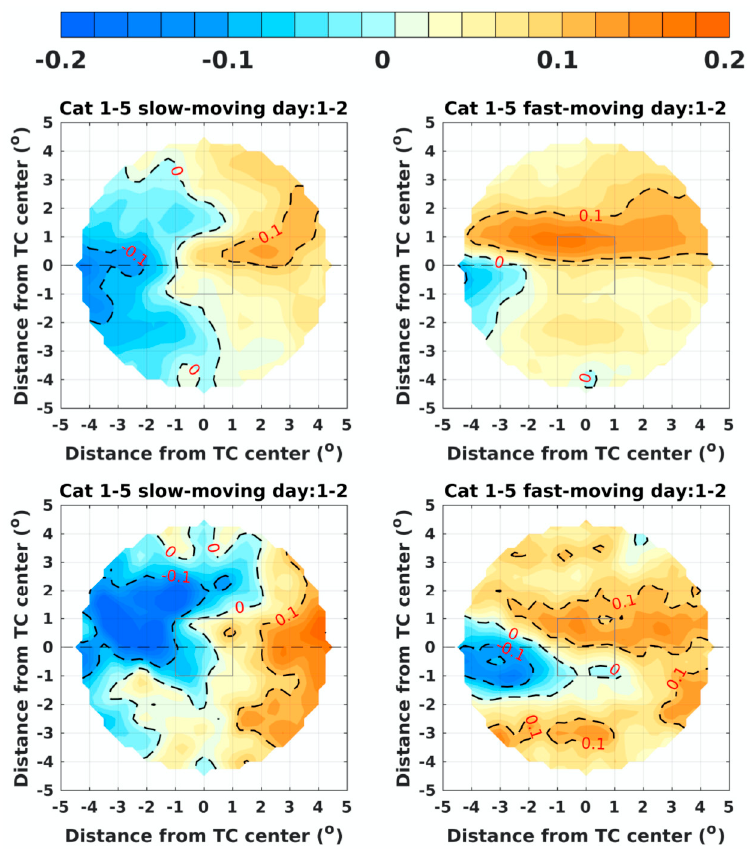
Figure 12. Distribution of SSS response (psu) to Category 1–5 TCs on days 1–2 in the Northern Hemisphere based on translation speed, with SMAP (upper panels) and SMOS (lower panels) swath daily data. Same time period from March 2015 to December 2019 is used for both SMAP and SMOS satellite data. The mean translation speed is 2.67 and 7.44 m s − 1 , respectively.